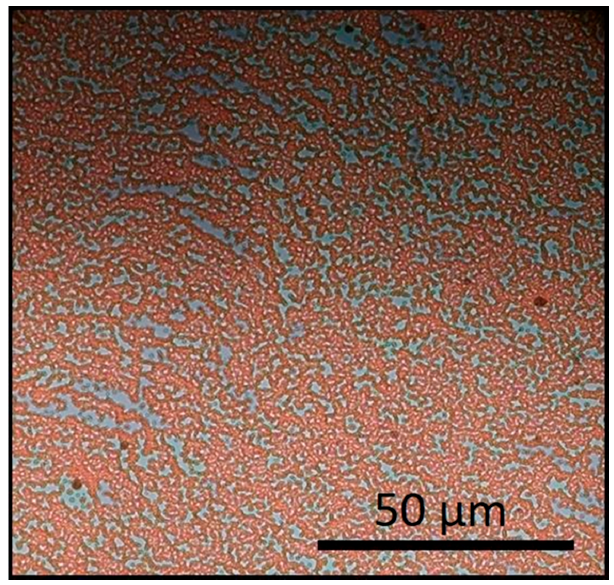
Figure 6. Self-assembly patterns of 536 nm diameter iron oxide superparamagnetic nanospheres (MSNs) under zero field.